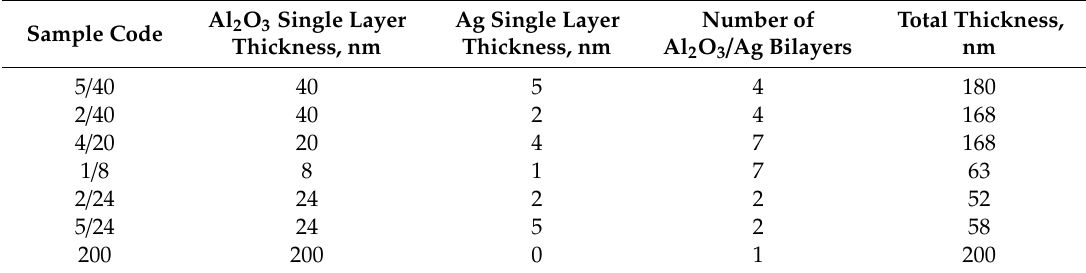
Table 1. Multilayer coatings composition